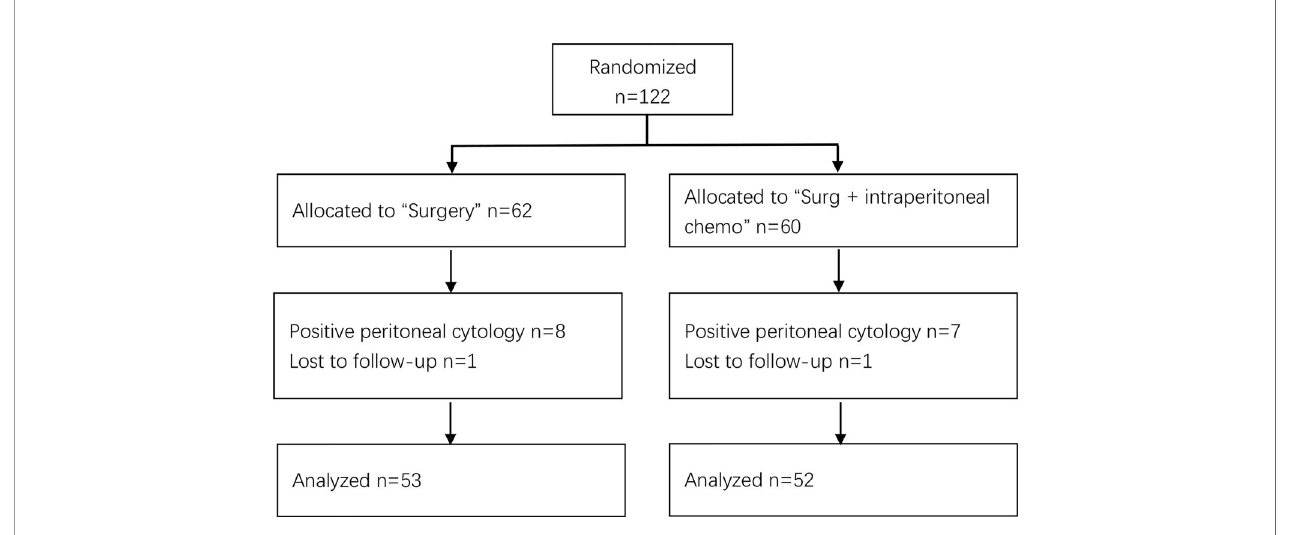
FIGURE 1 | Flowchart of the